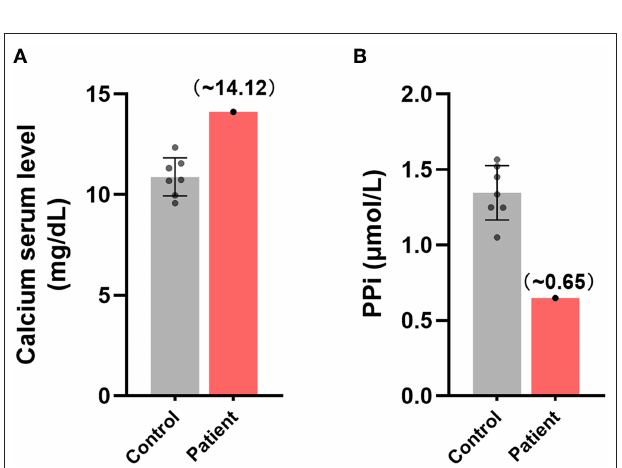
FIGURE 3 | Disturbances in the metabolism of ectopic calcification regulators in the plasma of this patient. Comparisons of the relative plasma concentrations of (A) free calcium and (B) inorganic pyrophosphate in this patient and control group.